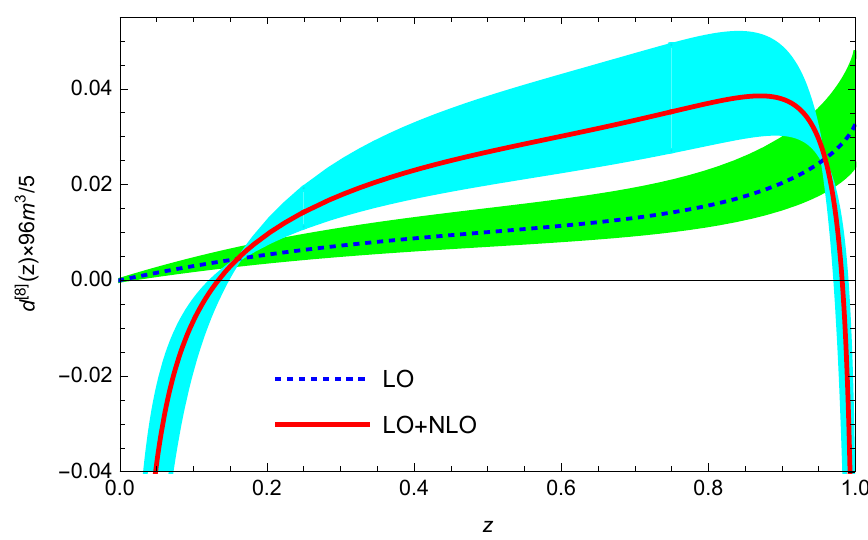
) + X at LO and NLO. The dotted 0 (cid:1) (cid:0) d [8] ( z ) + d [8] ( z ) (cid:2) (96 m 3 = 5), with scale b LO NLO